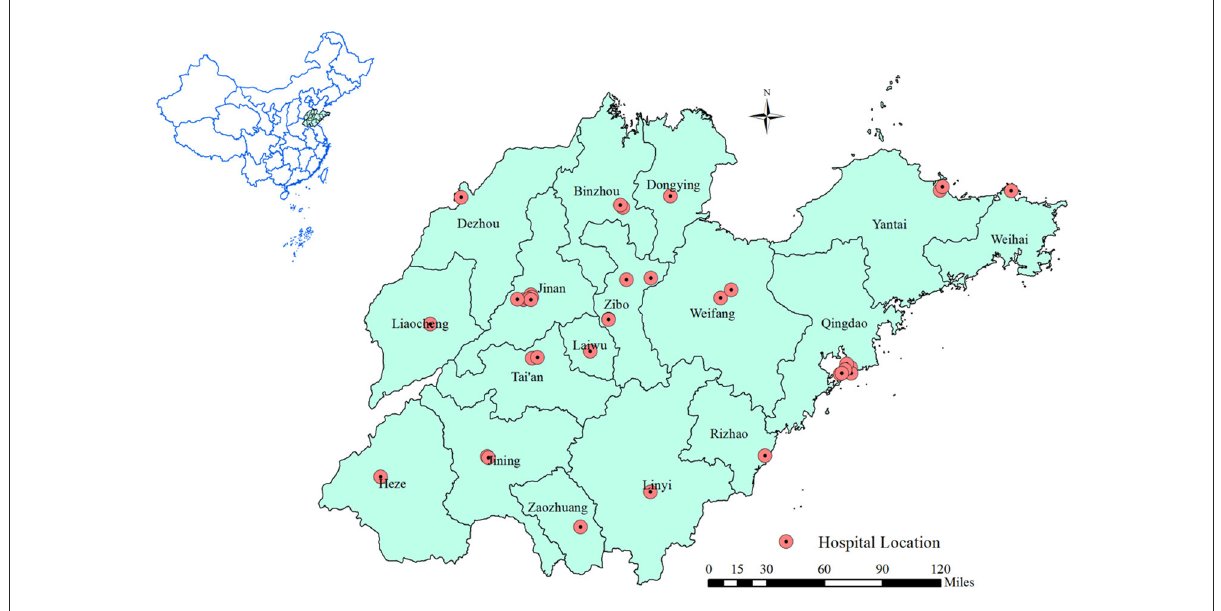
FIGURE1 The distribution of 36 hospitals in Shandong Province of